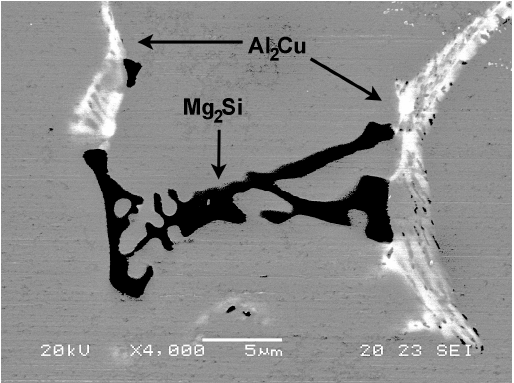
Figure 5. Microstructure of the material after continuous casting, obtained by scanning electron microscopy. Particles of Mg 2 Si (black coloring) and Al 2 Cu (white coloring) identified by semi ‐ quantitative analysis by characteristic energy dispersive X ‐ ray (EDX) microanalysis.